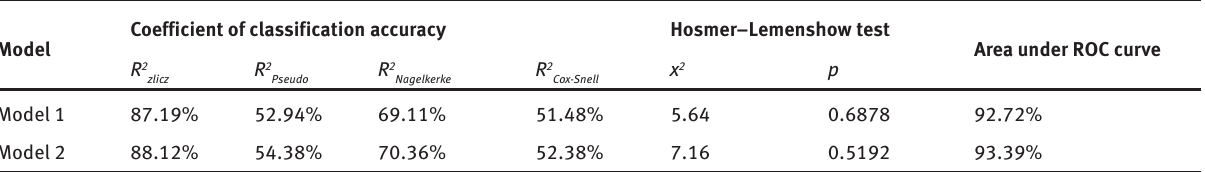
Table 15: Goodness of fit of the logistic models to the empirical data.